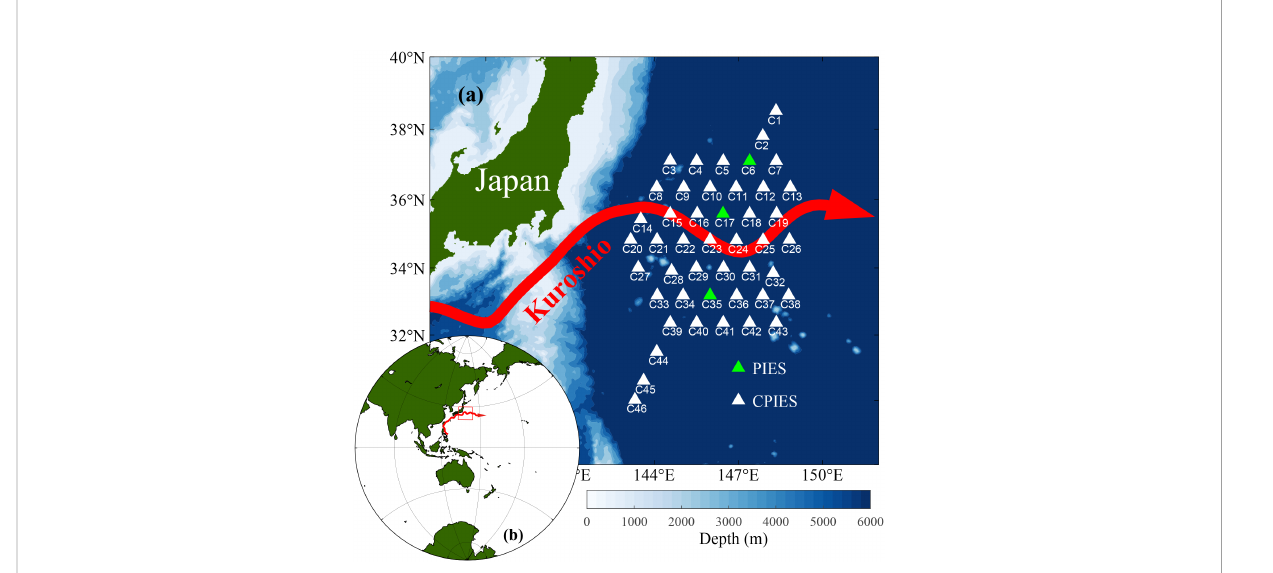
FIGURE 1 Schematic diagram of the Kuroshio Extension System Study (KESS) observation array. White and green triangles indicate pressure-equipped inverted echo sounders (PIESs) and current- and pressure-equipped inverted echo sounders (CPIESs), respectively [region shown in (A) is indicated by the red box in (B)